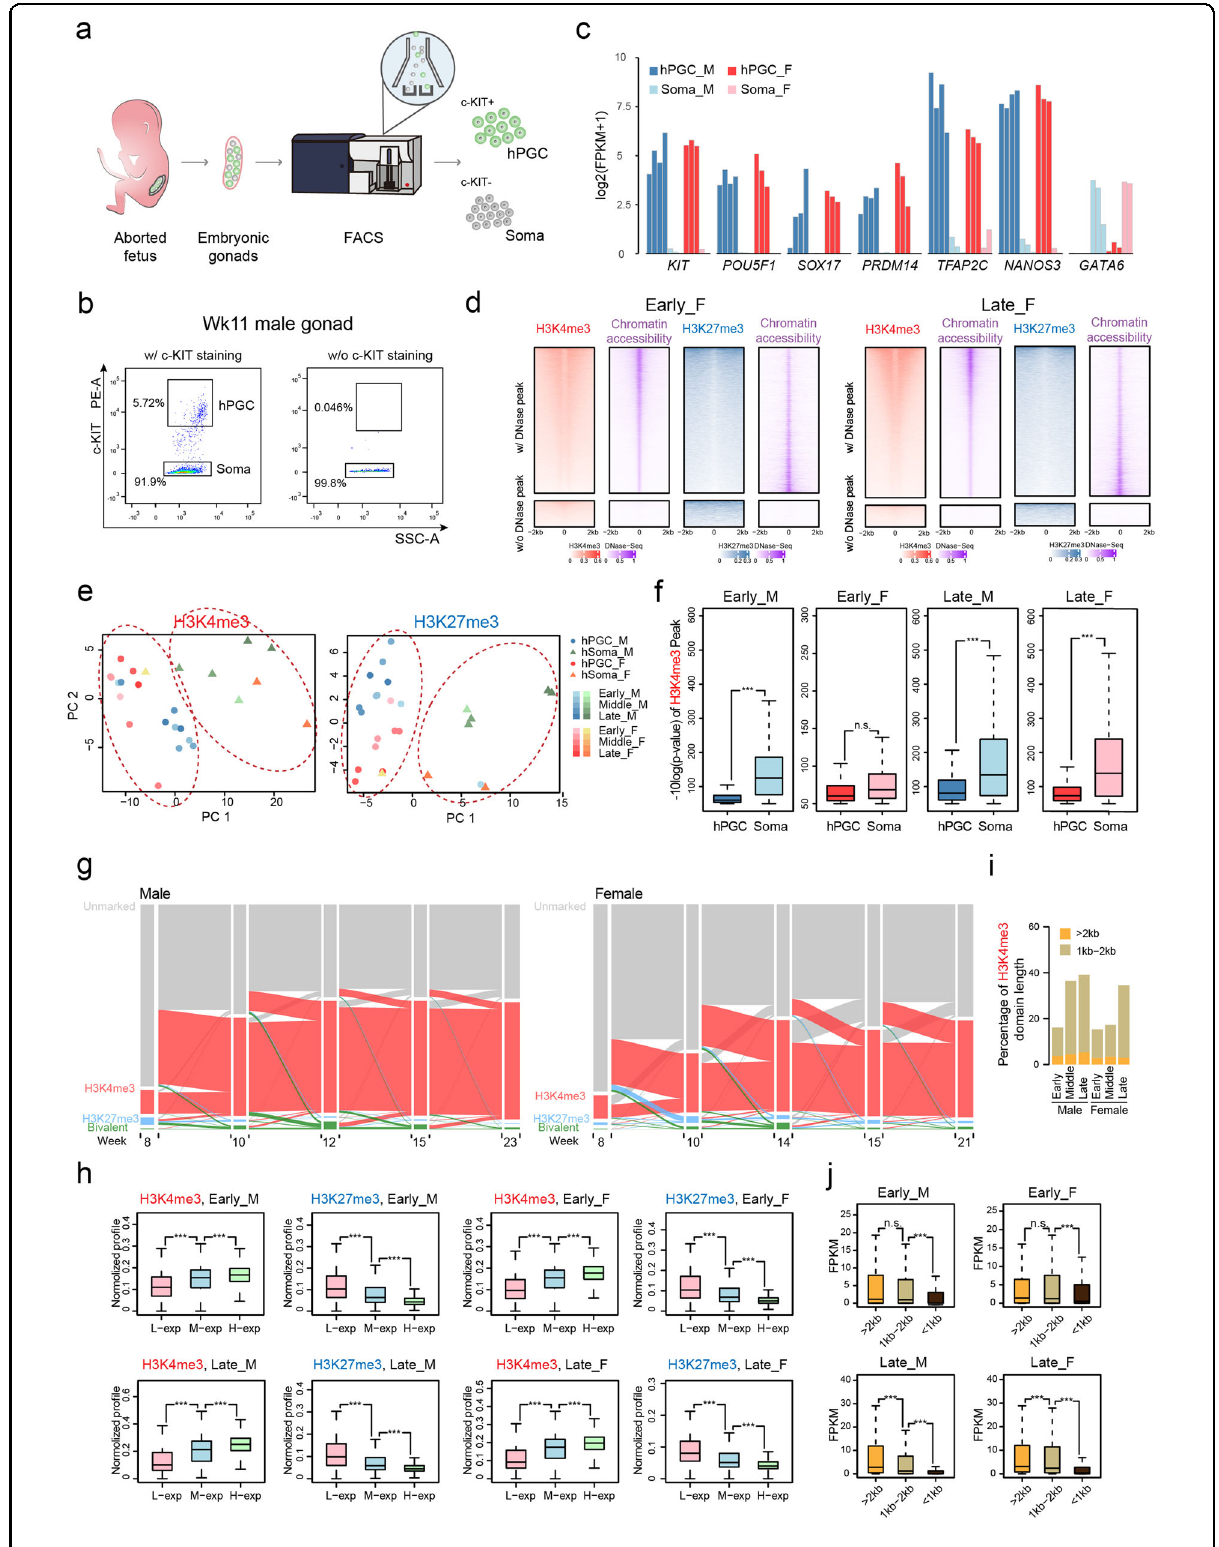
Fig. 1 (See legend on next